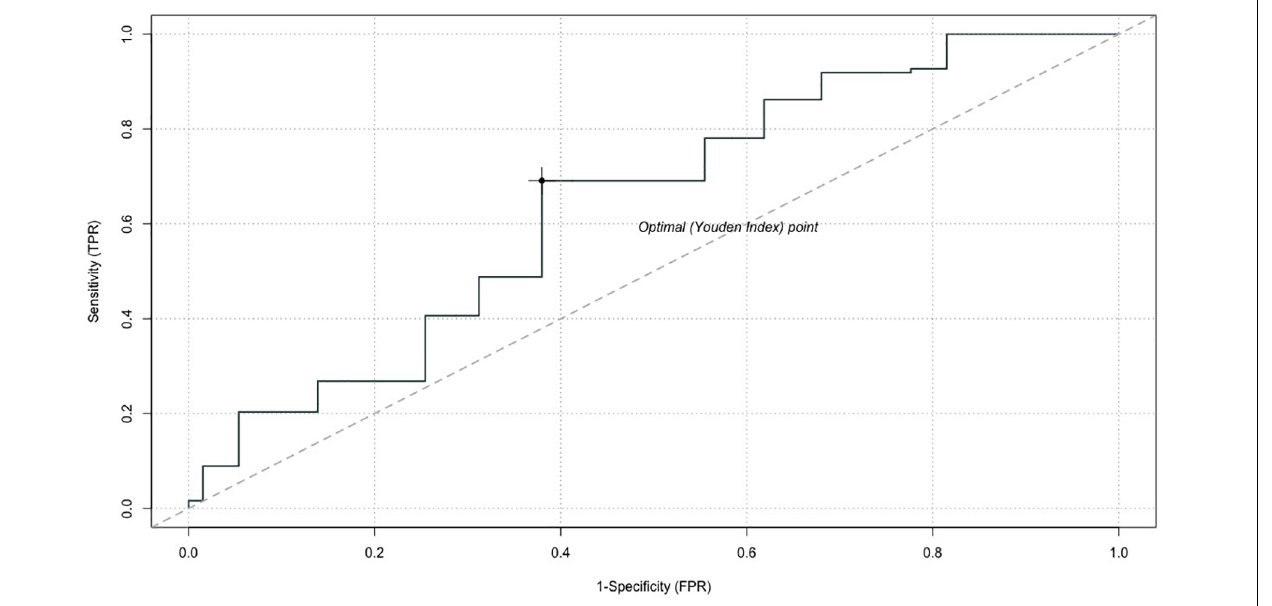
FIGURE 2 | Receiver operating characteristic (ROC) curve for the DRSc. AUC, area under the